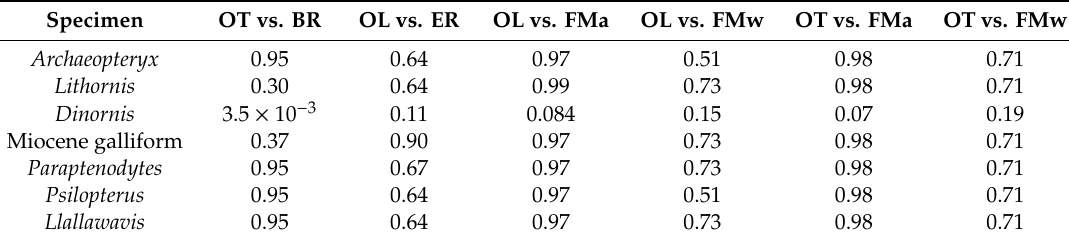
Table 5. Resulting p -values of the phylogenetic ANCOVA comparing the intercept of each extinct member of the sample to the intercept of the rest of the sample, given a common slope. These p -values have been adjusted with the Benjamini and Hochberg [89] procedure to control for false discovery rate; unadjusted p -values are available in Table S3. Significant di ff erences are highlighted in aqua. Abbreviations: BR, brain-remainder volume (brain volume minus optic-tectum